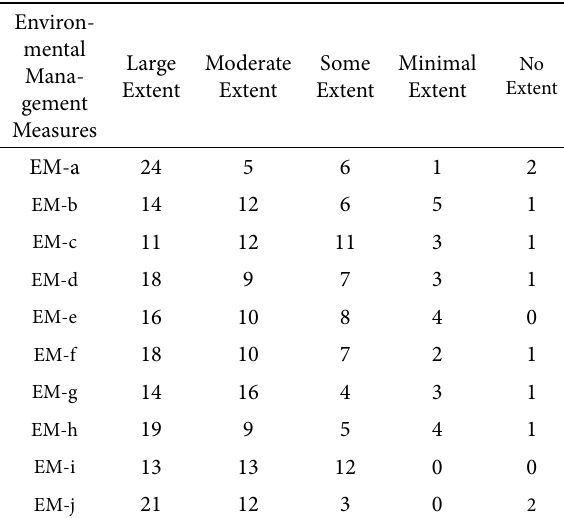
Table 5. Frequency distribution of participant responses to the strategies of implementing EMS in the Nigerian construction industry